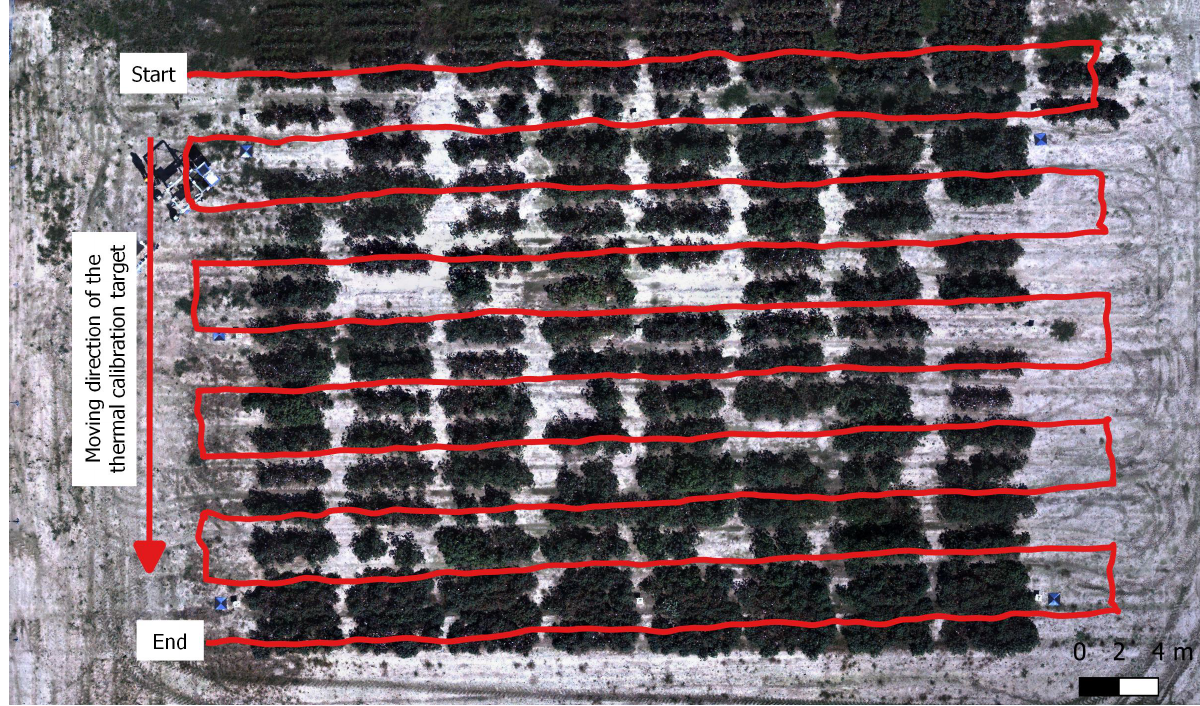
Figure 10. Flight path recorded by the UAV during data collection. Distance between horizontal flight paths is 3.3m. Direction of movement of thermal calibration targets is also indicated ( left